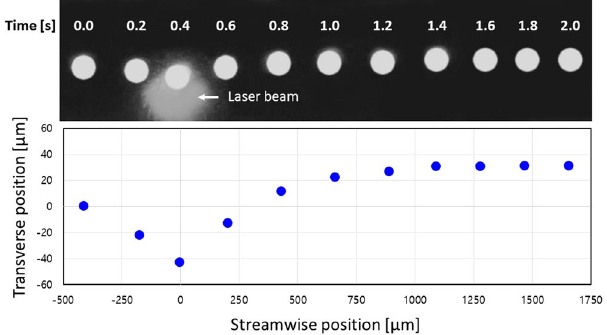
Figure 1. Trajectory shifting due to repulsive thermocapillary effects. The upper image was overlapped with 11 successive images captured at 0.2 s intervals. The lower graph shows the corresponding droplet trajectories. The streamwise position was set to zero at the laser beam center, and the transverse position was set to zero at the centerline of the channel. The shifting distance was defined as the difference in transverse positioning of the droplet between downstream and upstream. In this graph, the shifting distance was about 31.3 μ m. The streamwise velocity of the droplet was 1.16 mm/s, and the irradiated laser power was 70